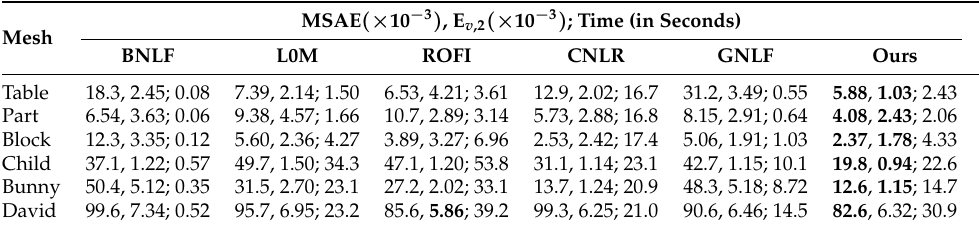
Table 1. Quantitative evaluation results of the tested mesh denoising methods. Mesh